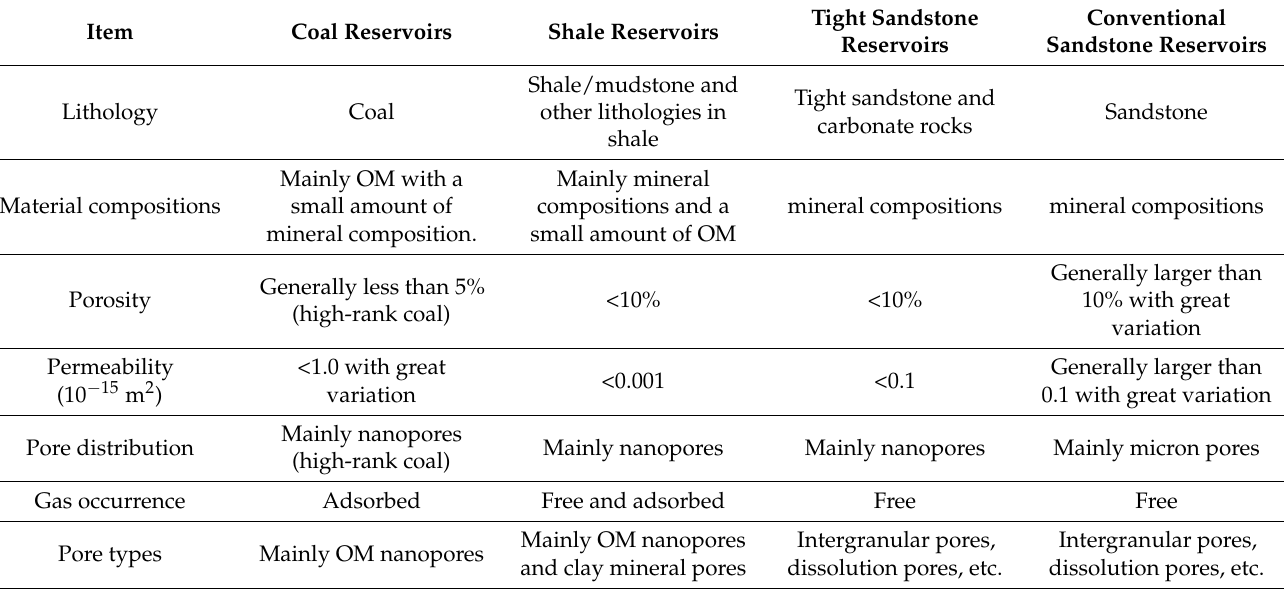
Table 4. A comparison of pore characteristics of coal, shale, tight sandstone, and conventional sandstone gas